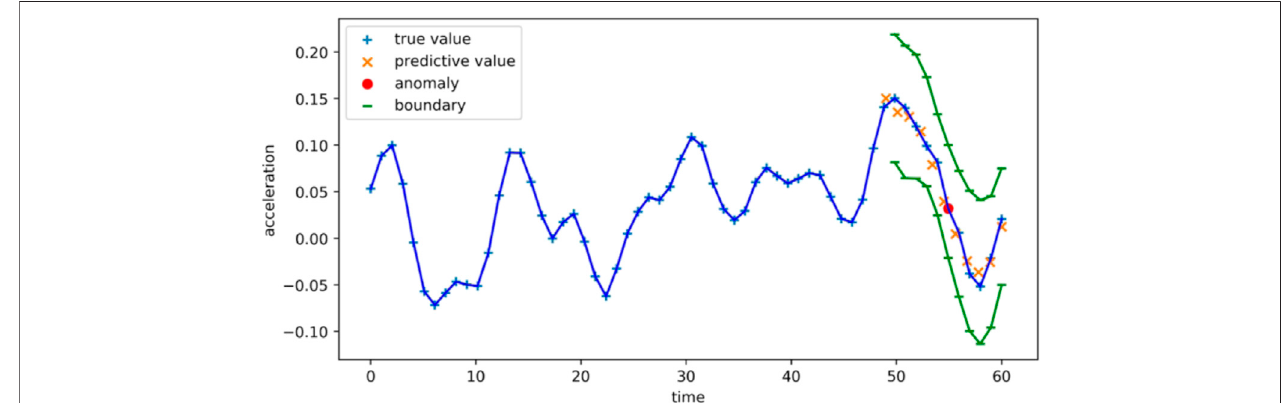
FIGURE 6 | CNN for anomaly detection.